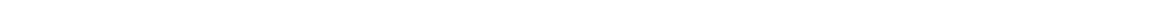
orally inoculated with indicated bacterial consortia as described in Fig. 4d. For upper airway colonization, indicated mice were intranasally inoculated with 10 6 CFU “ High Nod2-stimulating ” S . aureus and “ Low Nod2-stimulating ” S . gallinarum . Indicated groups were treated intranasally with rIL-17A, or vehicle control (5 μ g/mouse) concomitant with K . pneumoniae LPS inoculation. Statistical comparisons were by Student ’ s t -test, with a post-hoc Sidak – Bonferroni correction for multiple comparison where appropriate ( d – k ), and one-way ANOVA with post-hoc Sidak ’ s test ( l ), * P < 0.05, ** P < 0.01, *** P < 0.001, and NS, not signi fi cant. Each point represents a single mouse and horizontal lines indicate median values ( a , d , e , g – j